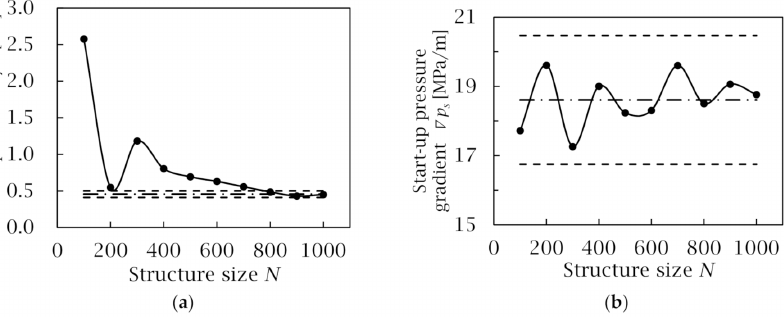
Figure 11. Results of ( a ) effective permeability and ( b ) start-up pressure gradient change with structure size. Long-dashed line is the estimated mean effective permeability (or start-up pressure gradient) and two short-dashed lines cover 10% variation from the mean effective permeability (or start-up pressure